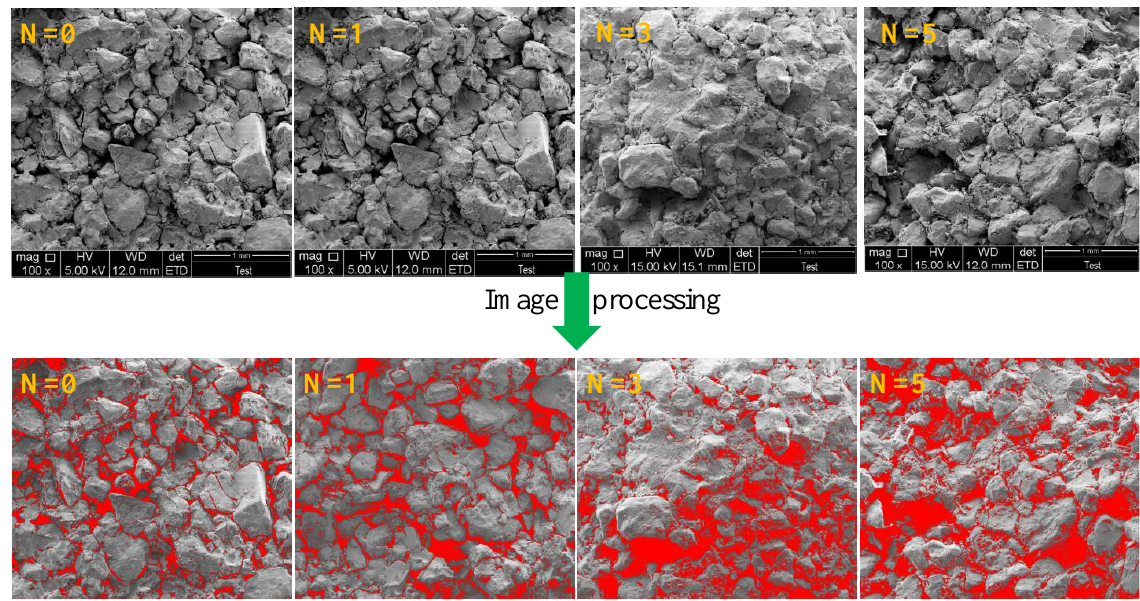
Figure 8. Image processing of specimens at different wet-dry cycles.